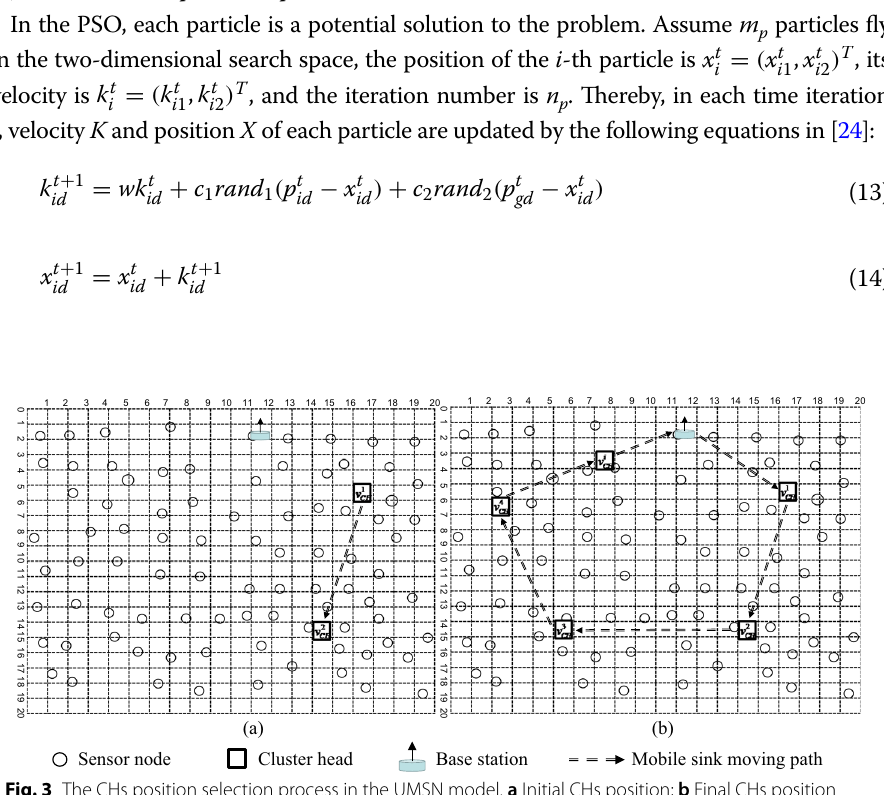
Fig. 3 The CHs position selection process in the UMSN model. a Initial CHs position; b Final CHs